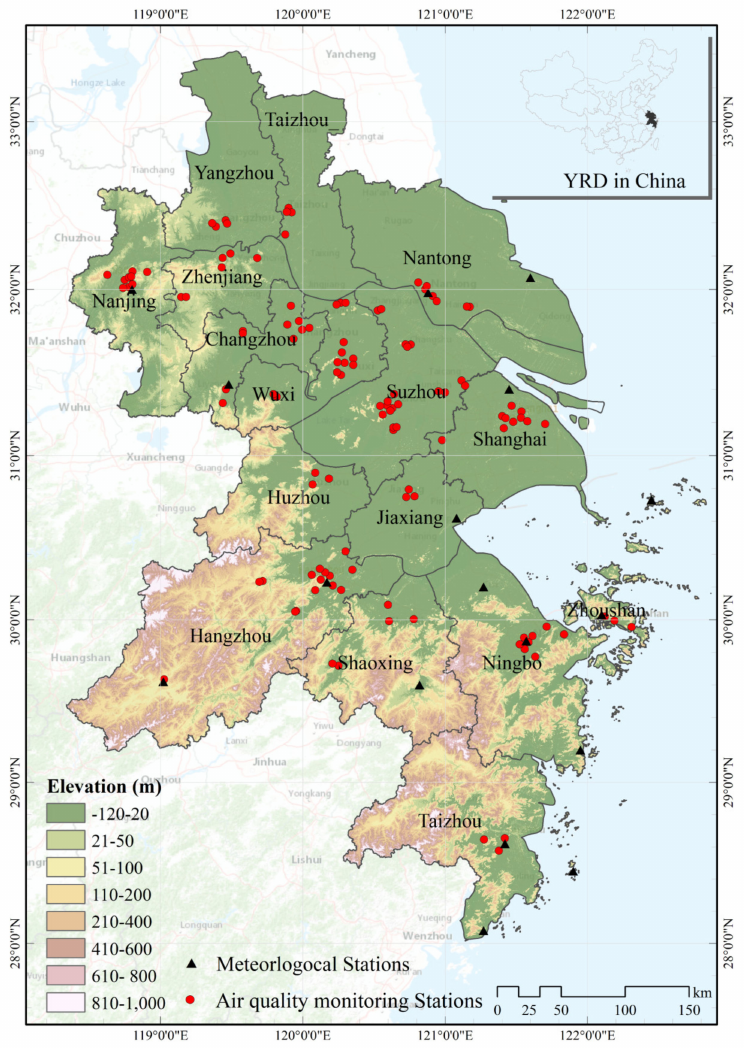
Figure 1. Location Map of the Yangtze River Delta.